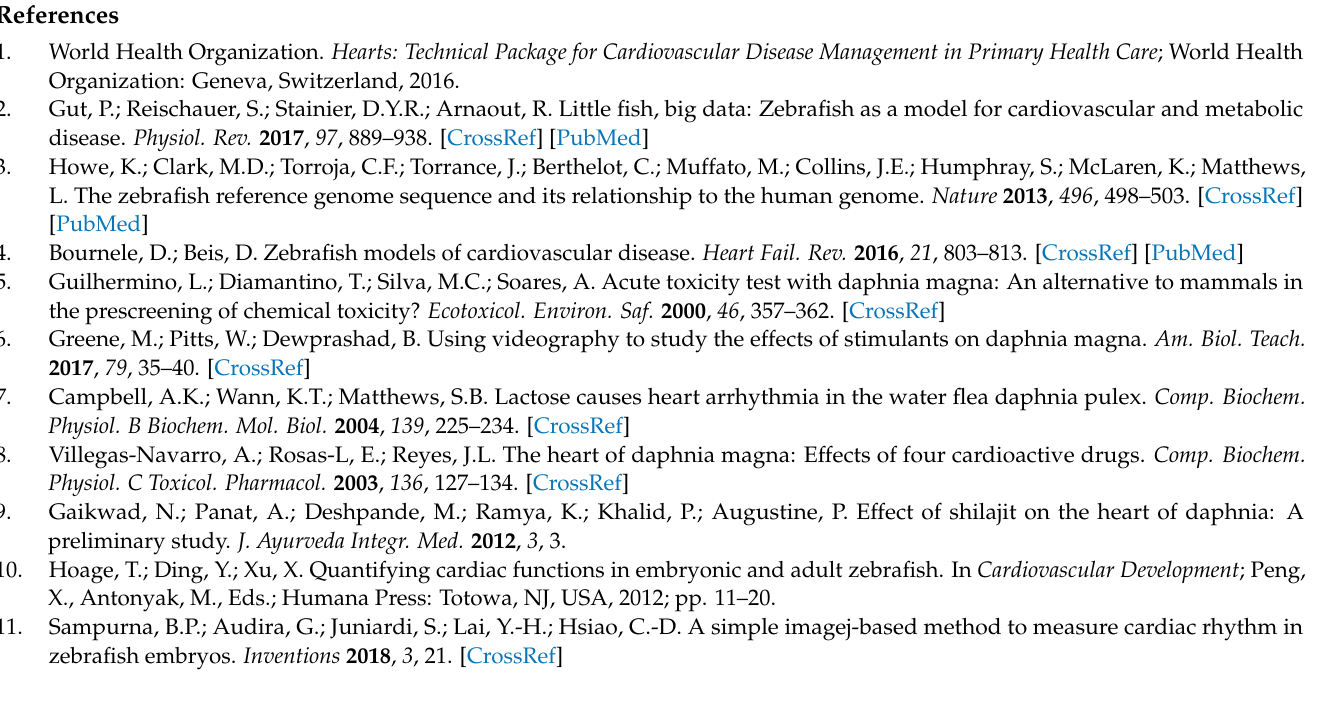
Figure A1. Comparison of peak acquired from either kymograph (upper panel) or time series analyzer (lower panel)